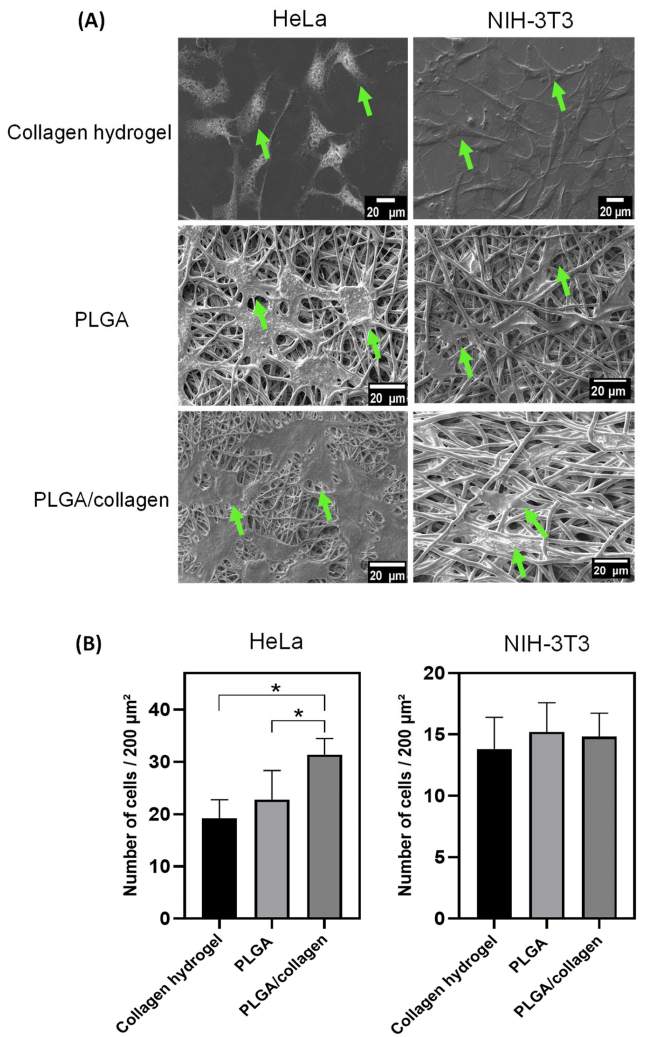
Figure 9. ( A ) SEM images of HeLa cells and NIH 3T3 attached to the collagen hydrogel, PLGA, and PLGA/collagen scaffolds for 48 h. ( B ) The number of HeLa cells and NIH 3T3 adhered to scaffolds. (* denotes a significant difference with a value p < 0.05, and arrows indicate the presence of cells on